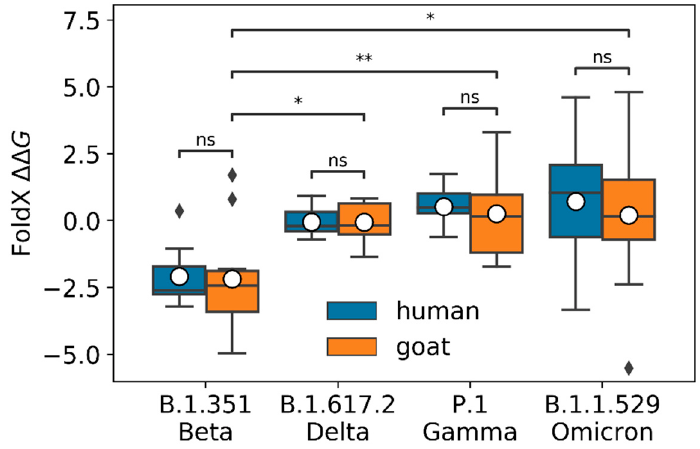
Figure 2. FoldX predicted ∆∆ G for B.1.351/Beta, B.1.617.2/Delta, P.1/Gamma, and B.1.1.529/Omicron variants for human and goat ACE2 (blue and orange boxes, respectively). For goat, the computed ∆∆ G was significantly lower for the Beta variant than for the Delta, Gamma, and Omicron variants, with Mann–Whitney–Wilcoxon test p -values of 1.06 × 10 − 2 , 3.64 × 10 − 3 , and 3.20 × 10 − 2 , respectively. The average ∆∆ G predicted from the 10 Modeller models is plot- ted as a white dot for each variant. We found no significant differences between the predicted ∆∆ G values for human and goat of the different variants (Mann–Whitney–Wilcoxon test p -values of 4.85 × 10 − 1 , 5.15 × 10 − 1 , 7.64 × 10 − 1 , 6.61 × 10 − 1 for Delta, Beta, Gamma, and Omicron, respectively). In this boxplot representation, the lower and upper ends of each box represent the first (Q1) and third (Q3) quartiles of the ∆∆ G predicted values, respectively. The horizontal line, inside each box, represents the median, or second quartile (Q2), and the mean is plotted as a white dot for each variant. The box “whiskers” extend to values that are 1.5 times the size of the interquartile range (IQR = Q3 − Q1). Values that fall outside this range are displayed independently as black diamonds. Mann-Whitney-Wilcoxon test p -values are annotated according to the following criteria: ns (0.05 < p -value ≤ 1), * (0.02 < p -value ≤ 0.05), ** (0.001 < p -value ≤